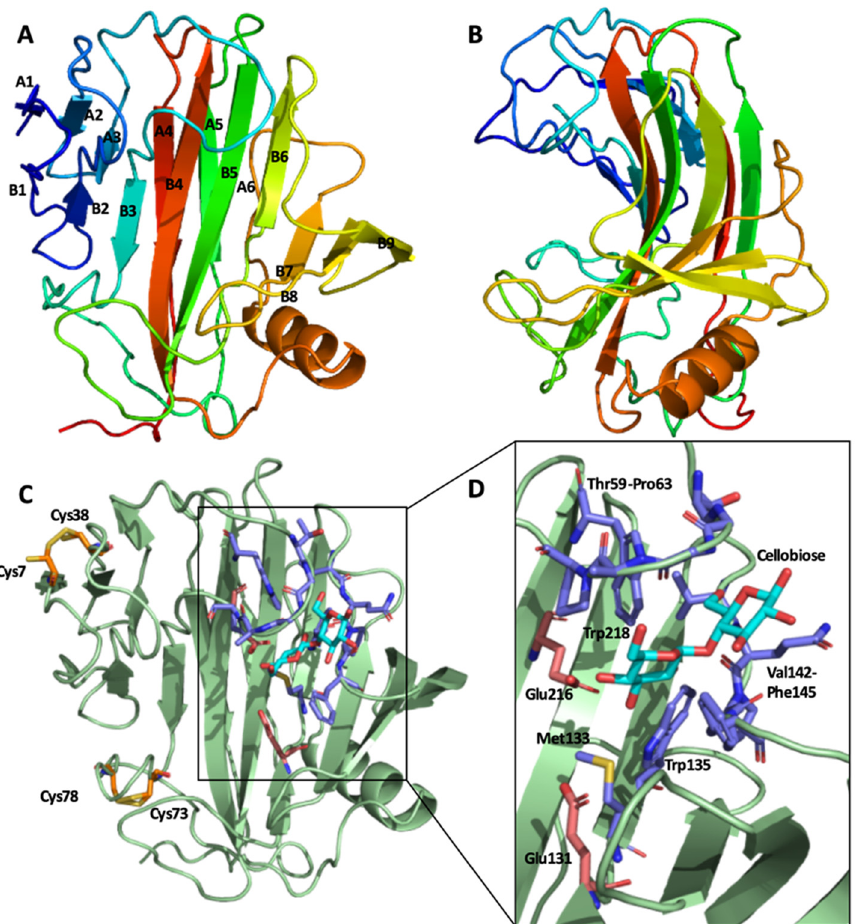
Figure 4. The crystal structure of the GuxA GH12 domain. ( A ) Viewed perpendicular to the β -jelly roll with β -strands labelled (N.B. strands A6 and B1, and parts of B7-B9 were not rendered as β - strands by PyMol). ( B ) The GH12 domain rotated 90° from A, viewed down the active site cavity. ( C ) Features of interest on the cellobiose bound structure—The two disulfides are shown in orange with cellobiose (cyan), the residues that coordinate it (blue) and the catalytic glutamate residues (light red) shown enlarged and reoriented in panel ( D ).